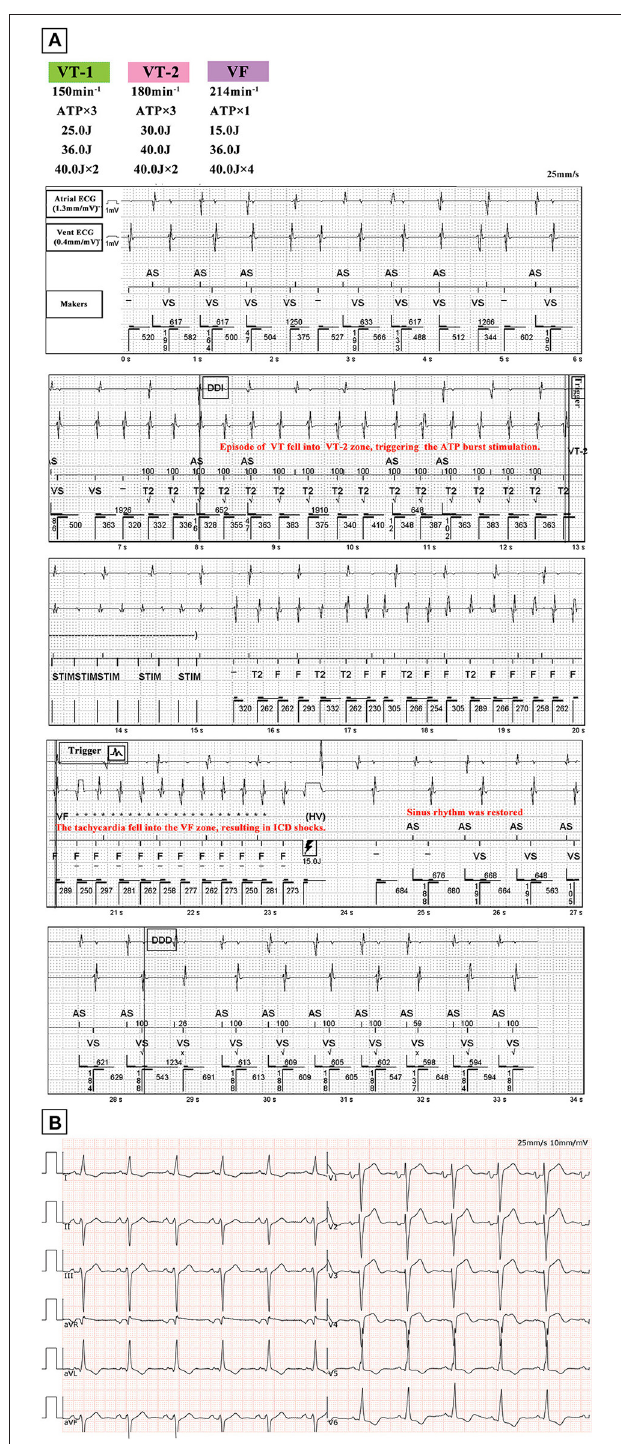
FIGURE 1 | (A) Episode of VT detected by ICD. Sinus rhythm is restored following one attempt of ATP burst stimulation with subsequent shock application according to the ICD programming protocol shown on the upper left corner. (B) ECG of the patient in sinus rhythm after shock therapy, with a QRS duration of 112ms. Abbreviations: VT, ventricular tachycardia; ICD, implantable cardioverter defibrillator; VF, ventricular fibrillation; ATP, antitachycardia pacing; vent,